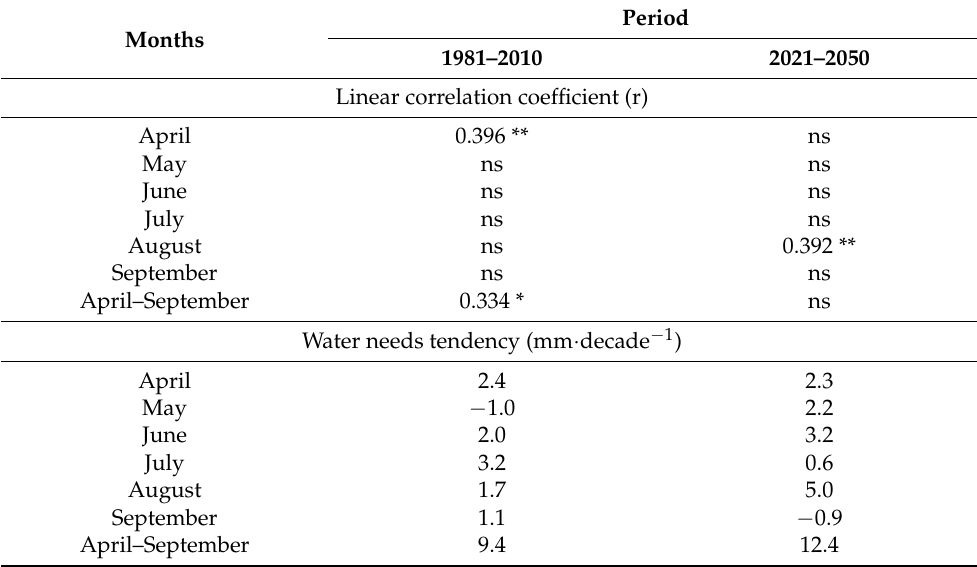
Table 3. Statistical significance of the equation trends for the water needs of sweet cherry trees and their tendencies in 1981–2010 and 2021–2050.